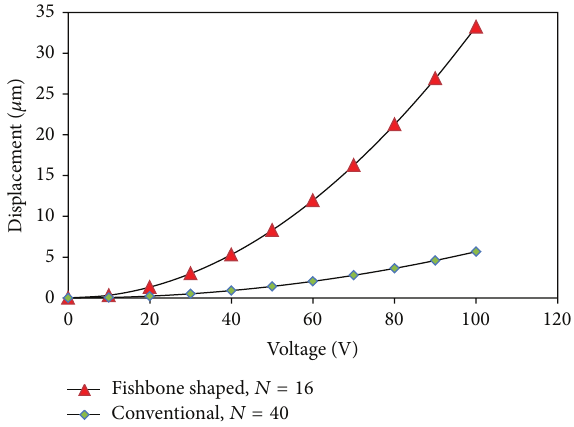
Figure 13: The relationships between driving voltage and displace- ment of the comb fingers in 𝑥 - direction for both multiple fingers of straight conventional comb driver and fishbone shaped comb driver.